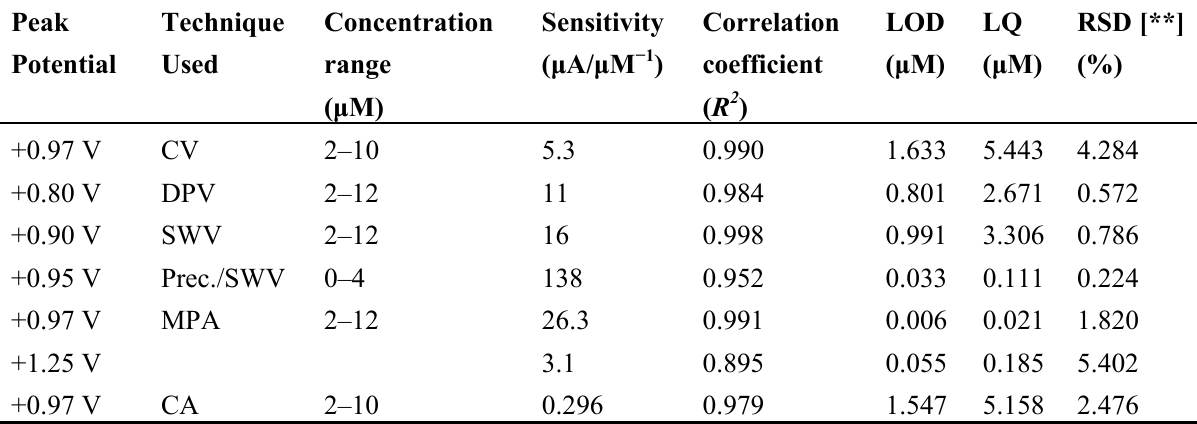
SO supporting electrolyte. 2 4